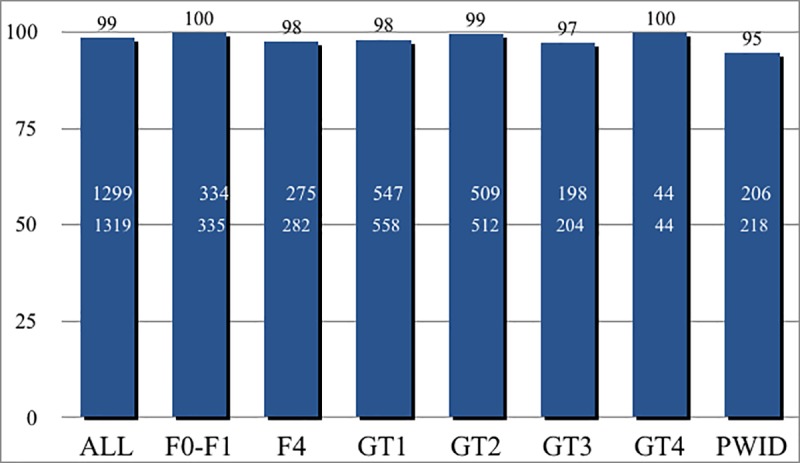
Proportion of patients with concomitant therapies.The figure shows the proportion of patients taking one ore more concomitant medications in this real world cohort. Only 191 patients (14.4%) were not taking concomitant medications. Up to 70% were taking 4 to 8 pill per day in addition to the antiviral treatment regimen.